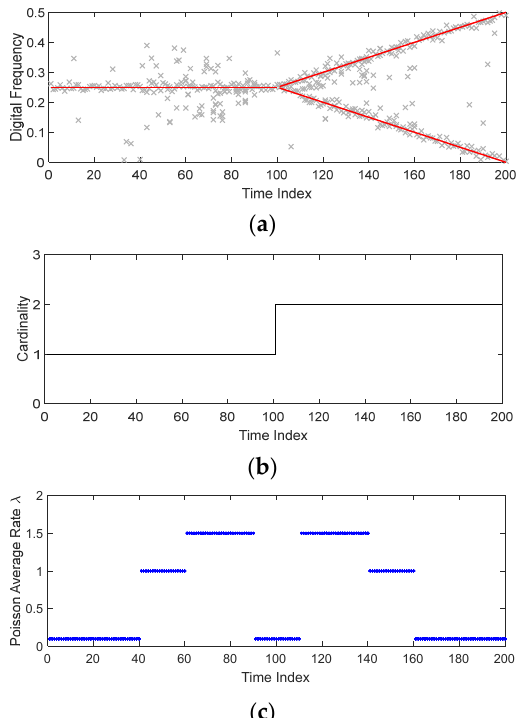
Figure 2. True trajectory (case 1): ( a ) Measurement and clutter; ( b ) Cardinality; ( c ) The Poisson average rate of clutter according to time index.